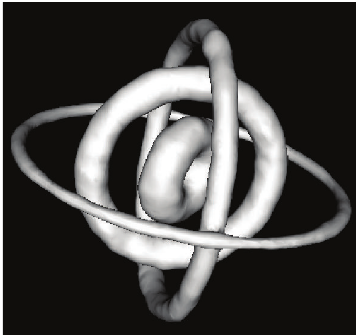
Figure 5: Surface rendering (OsiriX [23]) of solid rings recon- structed with 178 arcs and 32 noisy